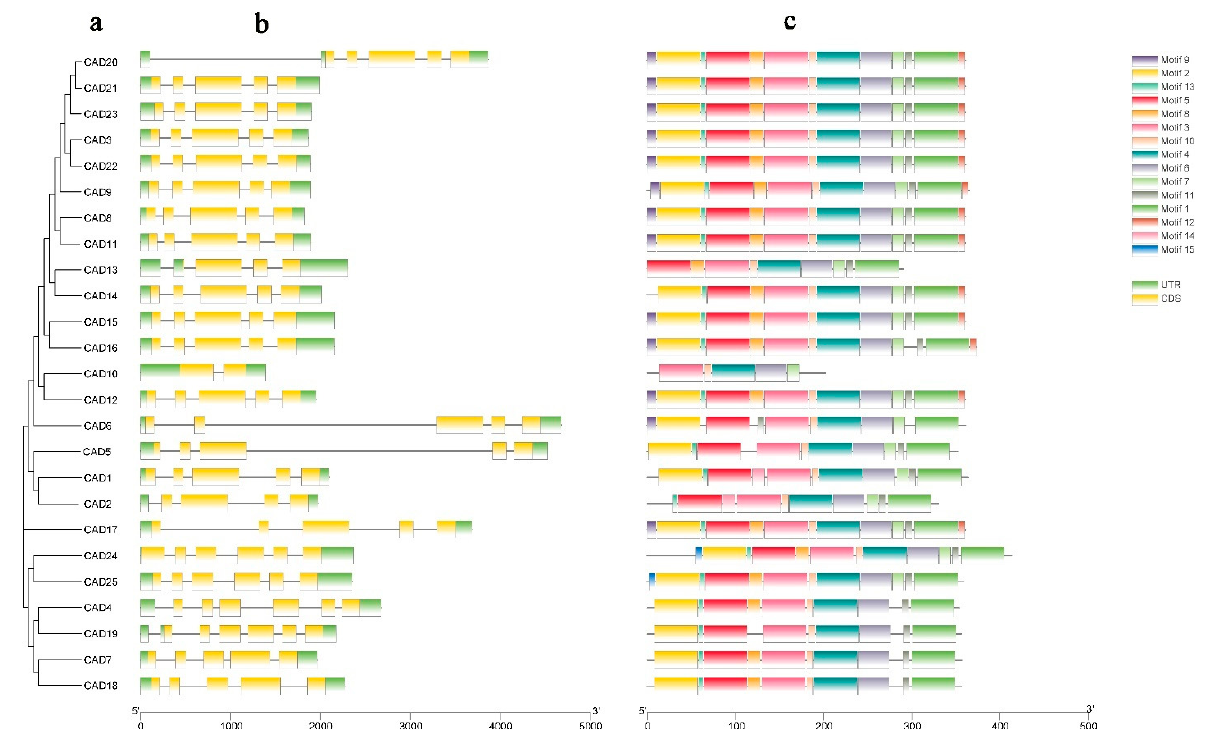
Figure 4. The gene structures and protein domains of PgCAD members. ( a ) Maximum likelihood phylogenetic tree of PgCADs ; ( b ) Gene structures of PgCADs . Green boxes indicated UTR, yellow boxes indicated CDS, and gray lines indicated introns. UTR: untranslated region, CDS: coding sequence; ( c ) Protein motif of PgCADs . They were named according to the E-value of the motif. The scale at the bottom indicates the sequence length.